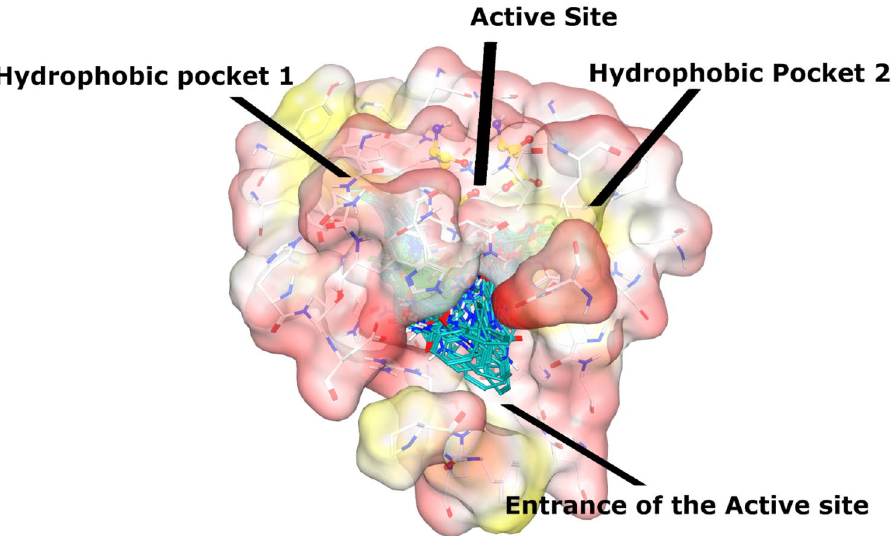
Figure 3. The docked view of all the compounds (shown in cyan stick model) is shown in the active site of α-glucosidase enzyme. The enzyme is presented in surface model where yellow and red colours shows hydrophobicity and hydrophilicity, respectively. The hydrophobic pocket 1 and 2 and the entrance loop of the active site shows hydrophobic behaviour. The catalytic residues are shown in yellow ball and stick model, while active site residues are depicted in white stick model.